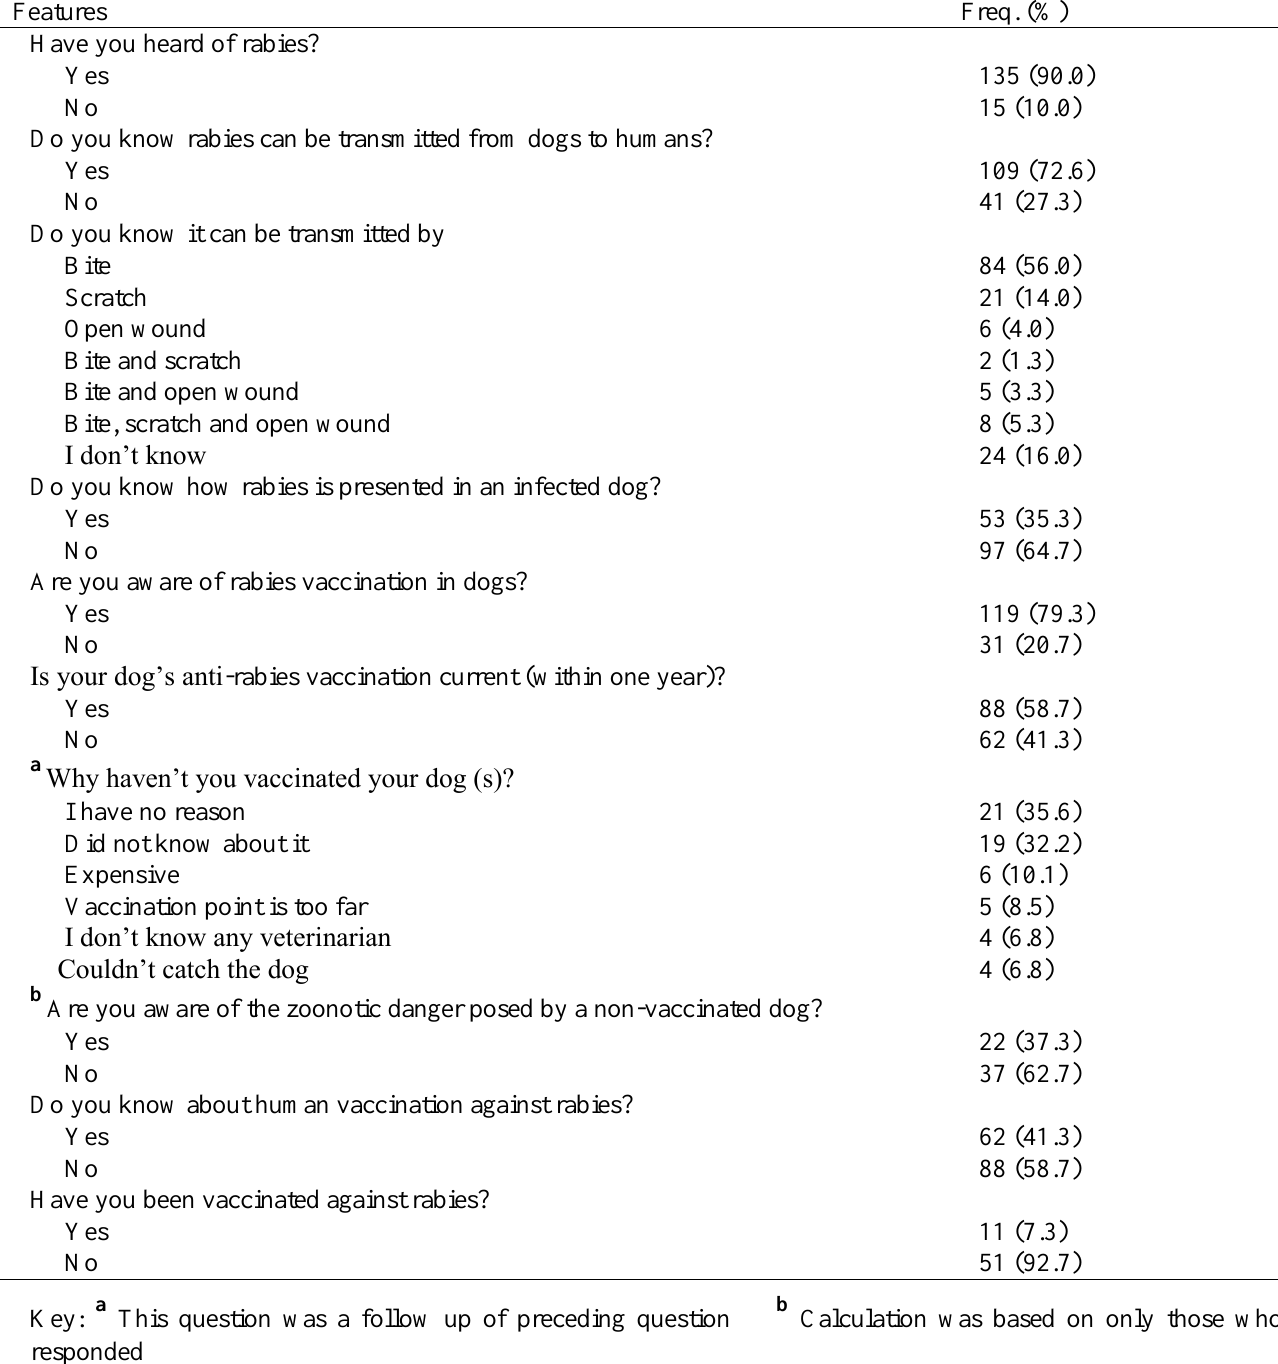
Table 3: Assessment of knowledge on